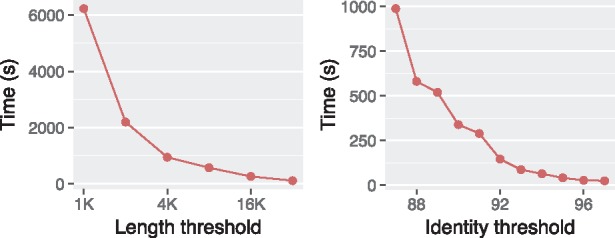
Wall time of Mashmap2 decreases with increasing length or identity thresholds using dataset D3 and eight CPU threads. In this experiment, identity and length thresholds were fixed to 90% and 10 Kbp while varying the other parameter. Memory-usage also follows a similar trend (data not shown)